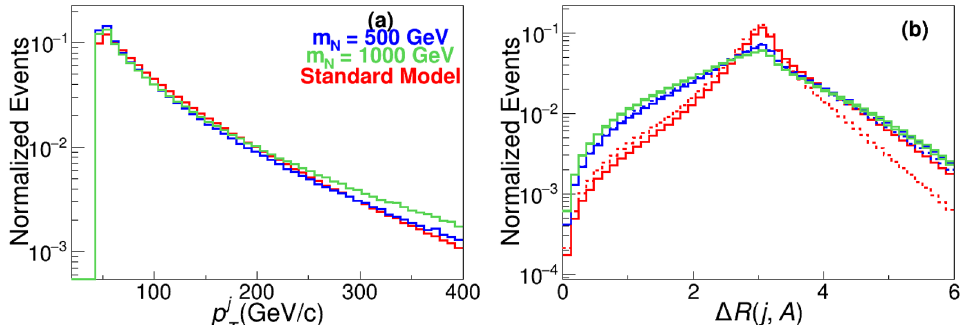
(left) and ∆ R ( j, A ) (right) of SM backgrounds Figure 7 . Distributions of jet relevant observables p j T (red) and heavy neutrino signals with m = 500 GeV (blue) and 1000 GeV (green) at N As the variable p ν is two-folded, the solid lines in the right panel correspond to the solution 0 z (larger absolute value of p ν ) and the dash lines to the solution 1 (smaller absolute value of p ν z distributions are normalised so that their integrals are equal to